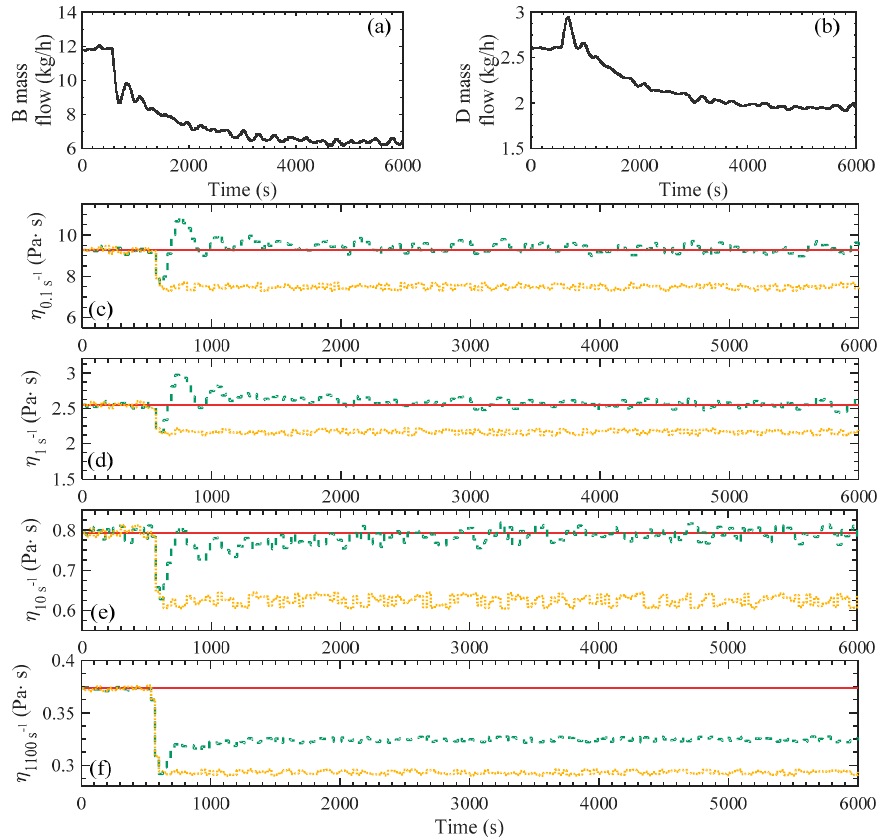
Figure 11. Performance of the controller responding to a disturbance (change of ingredient B) and comparison with the open loop response: ( a ) mass flow of ingredient B; ( b ) mass flow of ingredient D; ( c ) response of the viscosity at shear rate equal to 0.1 s − 1 ; ( d ) response of the viscosity at shear rate equal to 1 s − 1 ; ( e ) response of the viscosity at shear rate equal to 10 s − 1 ; ( f ) response of the viscosity at shear rate equal to 1100 s − 1 . For ( c – f ) the following data are reported: target curve (red solid line), measured value (green dashed line), open loop evolution of the process (orange dotted line).